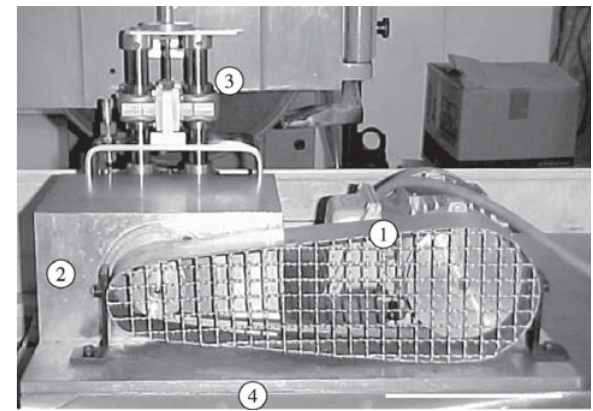
Figura 2. Fotografia do conjunto banco de ensaios/cabeçote de testes, juntamente com o motor de acionamento, posicionados sobre a mesa da máquina retificadora. Elementos: motor elétrico (1), o cabeçote (2), o sistema cursor de deslocamento (3) e a placa de aço (4) que serve de base para o conjunto descrito.